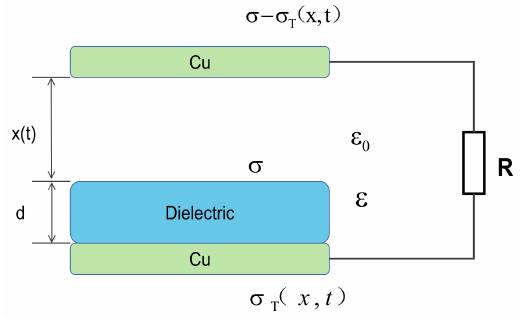
Figure 10. Theoretical model of CS-TENG in vertical contact-separation